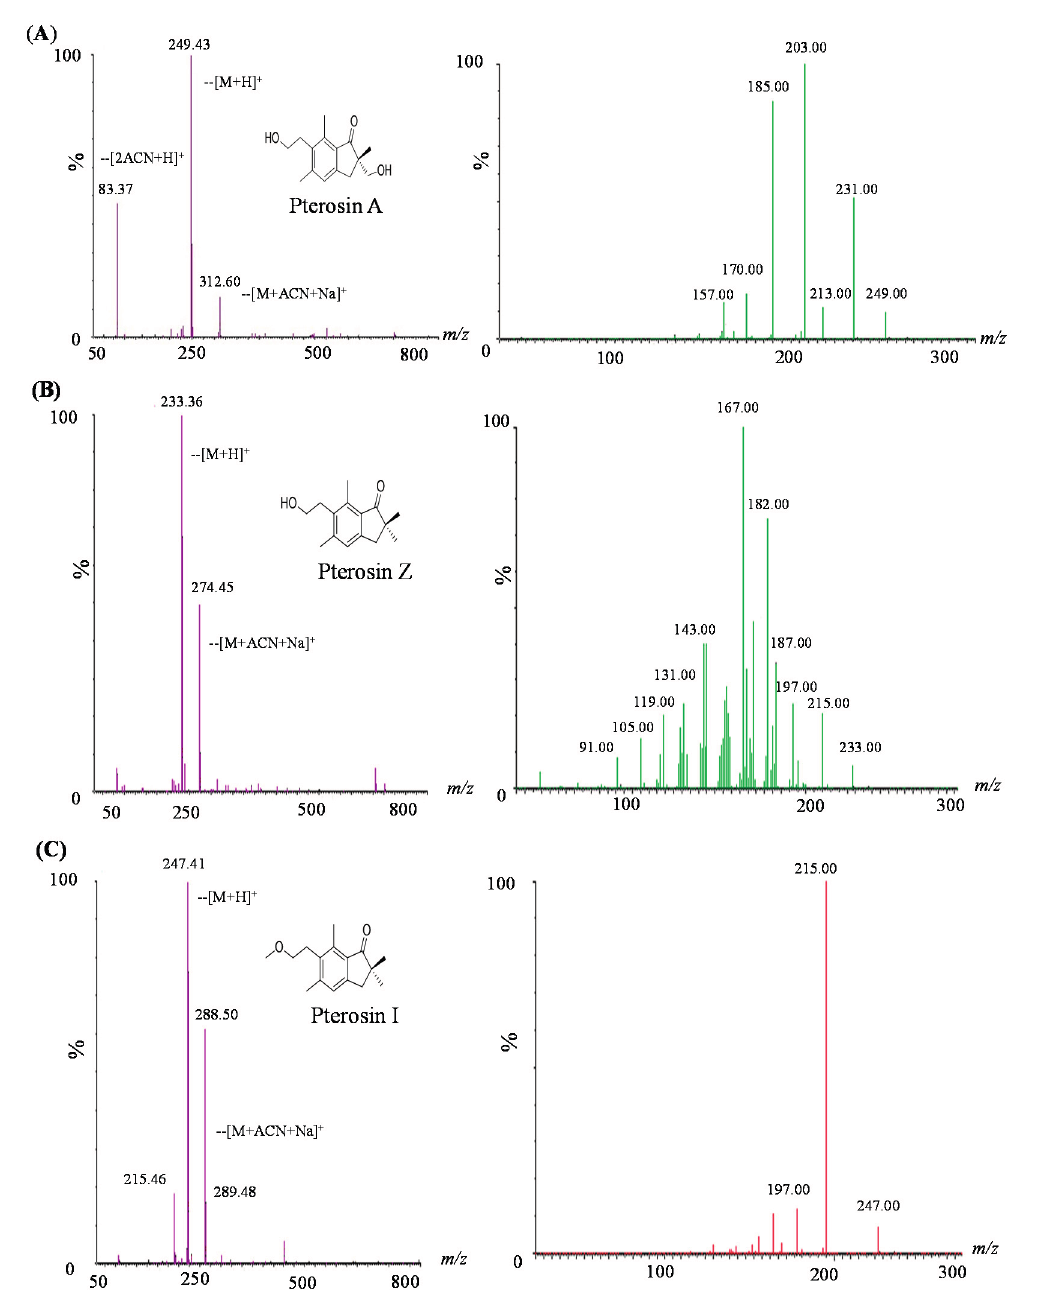
Figure 4. First mass scan analysis and daughter ion mass spectra of three pterosins: ( A ) pterosin A; ( B ) pterosin Z; and ( C ) pterosin